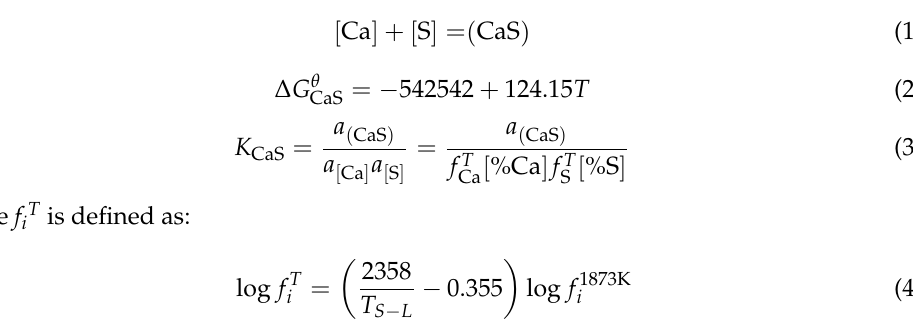
Figure 2. Schematic representation of sampling locations in steel samples.